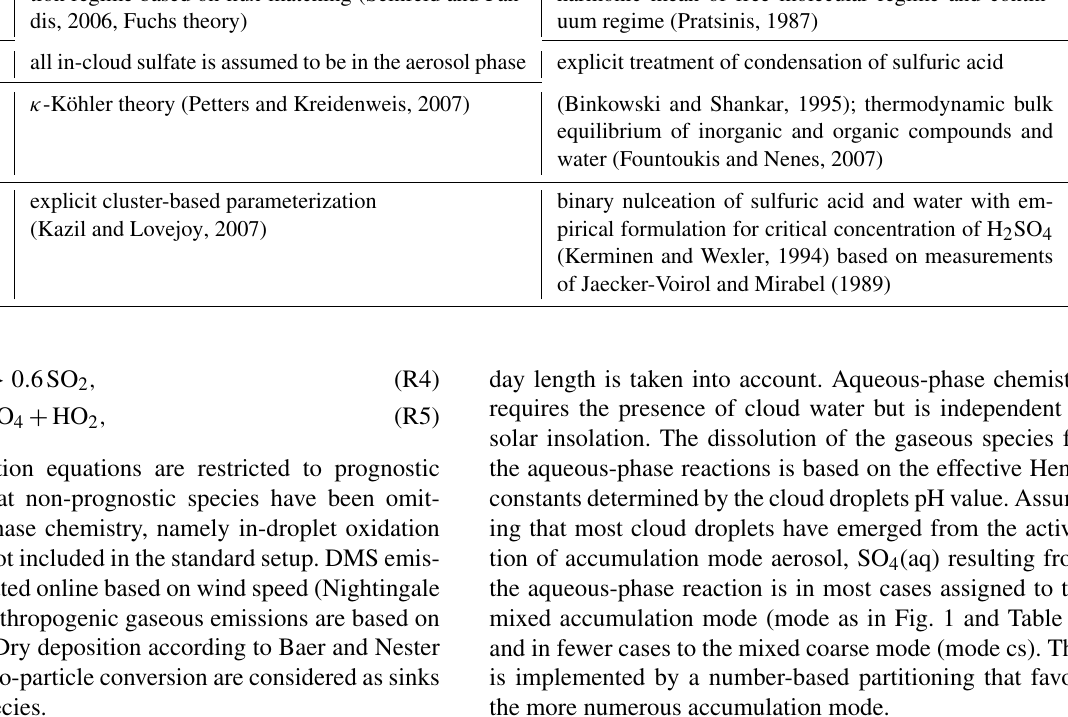
Table 2. Comparison of aerosol dynamical processes for MADE and M7. M7 MADE Coagulation coagulation and condensation coefficients for the transi- coagulation coefficients due to Brownian diffusion as tion regime based on flux-matching (Seinfeld and Pan- harmonic mean of free molecular regime and contin- dis, 2006, Fuchs theory) uum regime (Pratsinis, 1987) Condensation all in-cloud sulfate is assumed to be in the aerosol phase explicit treatment of condensation of sulfuric acid Water uptake κ -Köhler theory (Petters and Kreidenweis, 2007) (Binkowski and Shankar, 1995); thermodynamic bulk equilibrium of inorganic and organic compounds and water (Fountoukis and Nenes, 2007) Nucleation explicit cluster-based parameterization binary nulceation of sulfuric acid and water with em- (Kazil and Lovejoy, 2007) pirical formulation for critical concentration of H 2 SO 4 (Kerminen and Wexler, 1994) based on measurements of Jaecker-Voirol and Mirabel